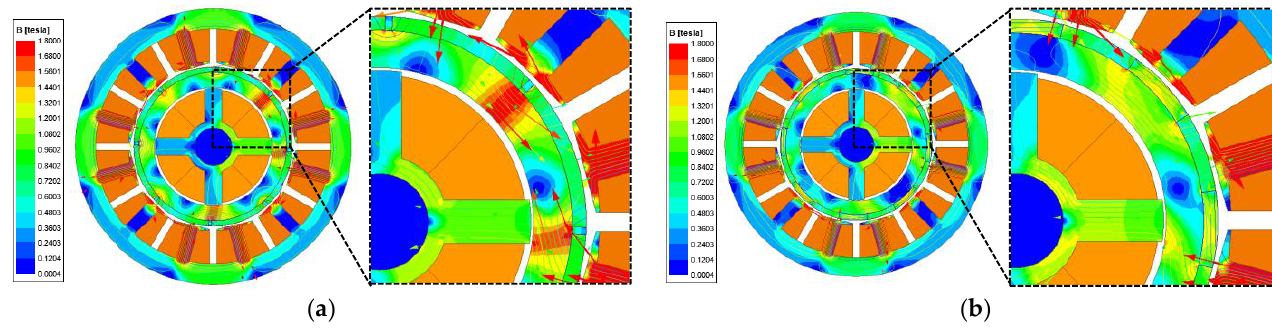
Thickness of magnet